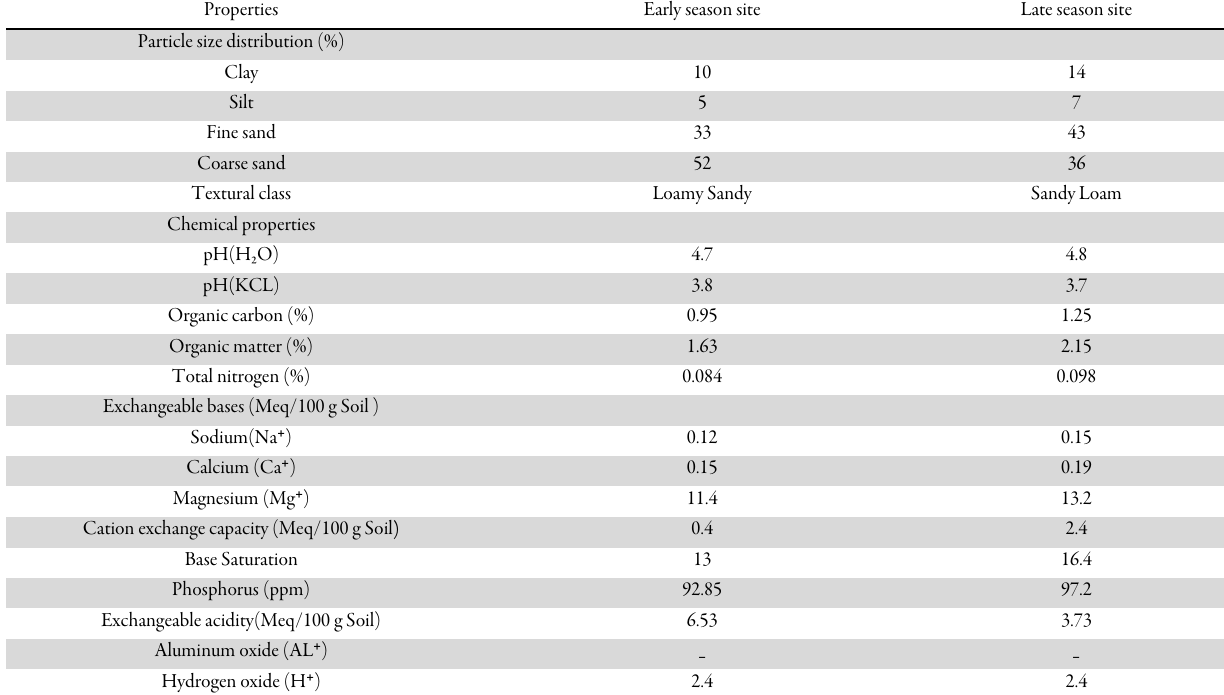
Table 1. Physical and chemical properties of the soil of the experimental sites